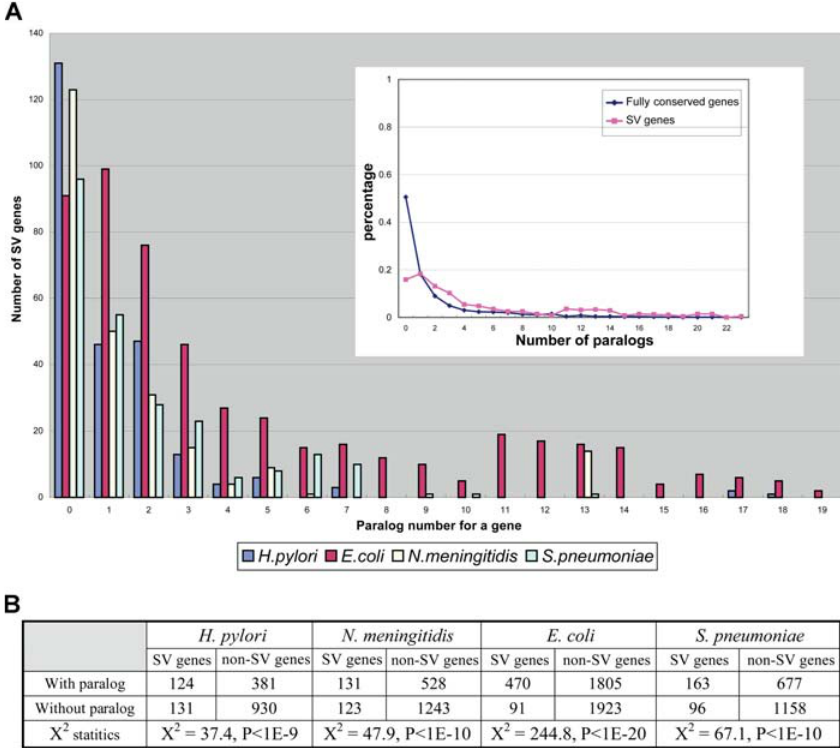
Figure 7. Paralogous Genes in SVGs (A) Paralog families in SVGs for four microorganisms. The x-axis shows the number of paralogs for each SVG. The y- axis shows the number of SVGs. The inset figure shows the percentage of genes with different numbers of paralogs for SVGs and fully conserved genes in E. coli genome. The x-axis is the number of paralogs, and the y-axis is the percent- age. (B) Contingency tables to examine the dependence between SVG and paralo- gous gene. v 2 statistics are computed using standard